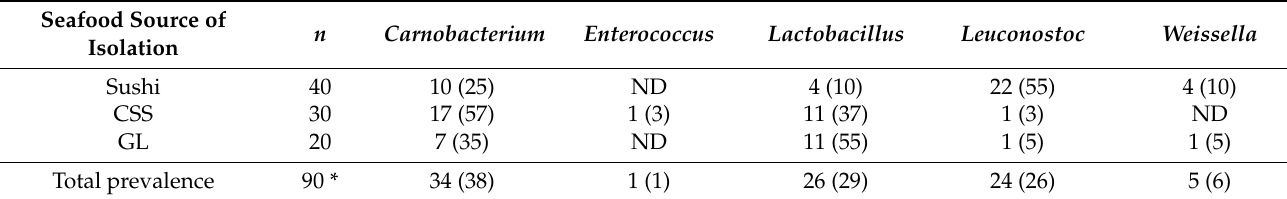
Figure 1. Box plot of the log-transformed LAB counts from cold-smoked salmon (CSS, n = 96), gravlax (GL, n = 44), and sushi ( n = 57). The solid horizontal line inside the box indicates the median, and whiskers indicate the range. Boxes with different letters have means that are significantly different ( p < 0.05). Table 1. Number (percentage) of different genera of lactic acid bacteria (LAB) sampled from sushi, cold-smoked salmon (CSS), and gravlax